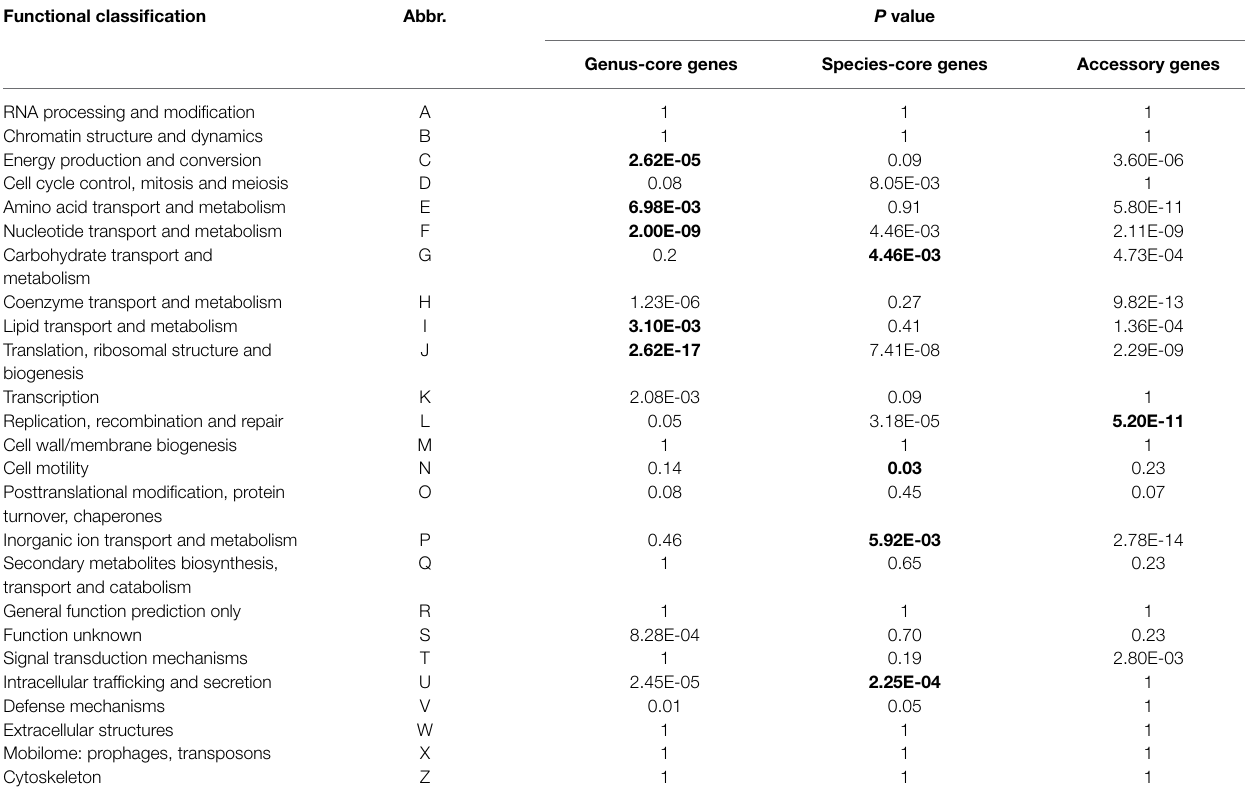
TABLE 2 | Functional enrichment analyses of genes in Pectobacterium aroidearum QJ036. Functional classification